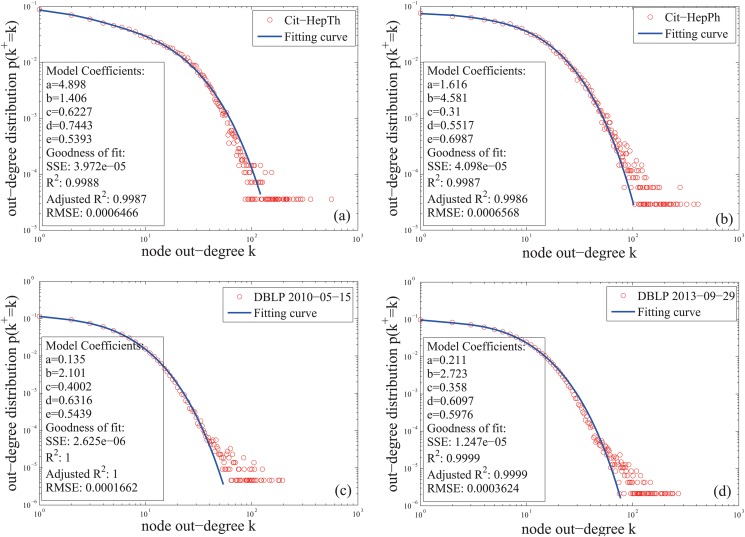
Out-degree distributions of the citation networks in Table 1 and the fitting curves of the distributions.The fitting model is the mixture generalized Poisson distribution (Equation (14)).